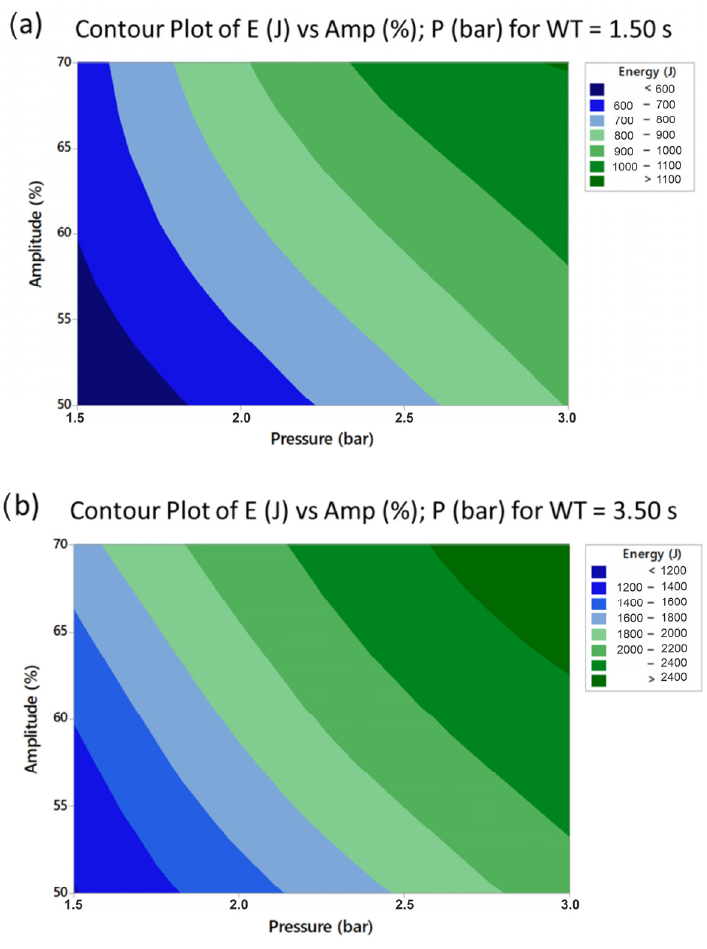
Figure 12. Contour plots of energy vs. amplitude and pressure at constant welding time. The lap shear strength represents the second response of the DoE in the present work.